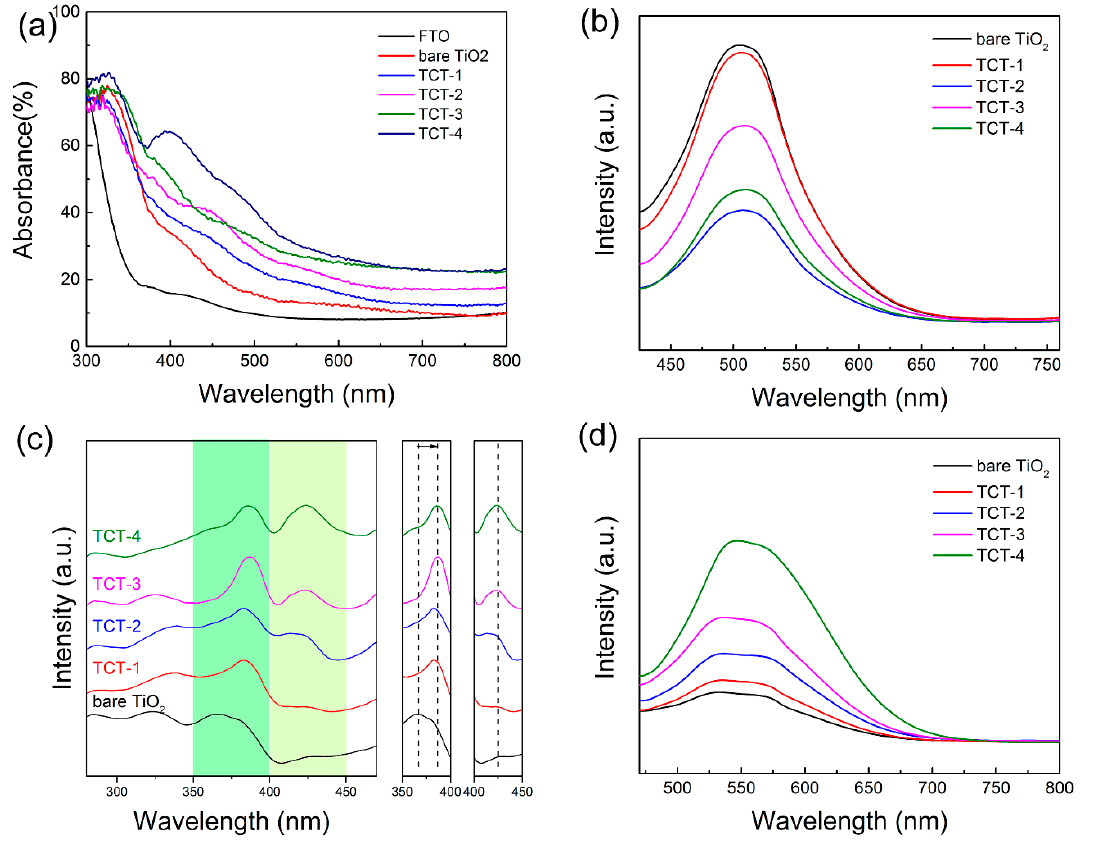
Figure 6. ( a ) UV–vis spectra of FTO substrate, bare TiO 2 and TCT samples, respectively; ( b ) photoluminescence spectra of all samples with the excitation wavelength at 390 nm; ( c ) PL spectra of all samples with the emission wavelength at 512 nm; and ( d ) PL spectra of all samples with the excitation wavelength at 425 nm.